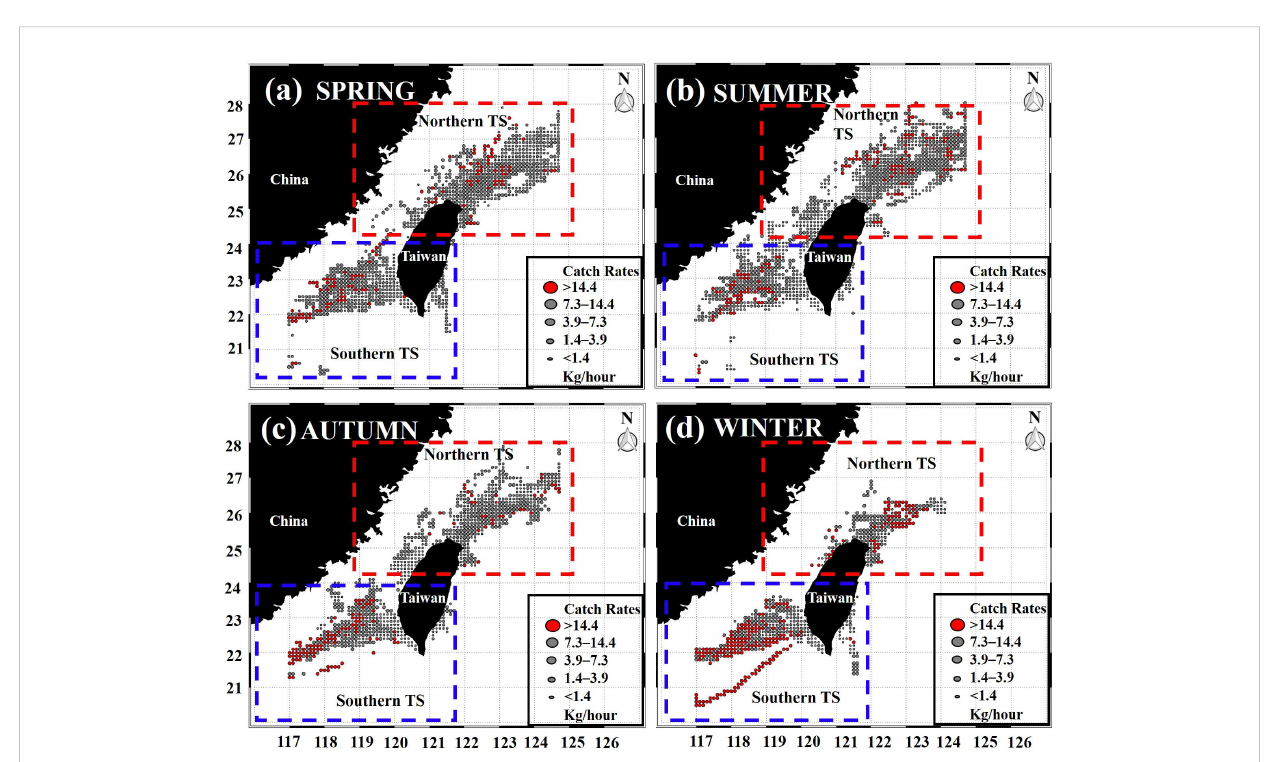
FIGURE 4 Seasonal average catch rates of greater amberjack in the southern (blue color box) and the northern (red color box) Taiwan Strait in 2014 –